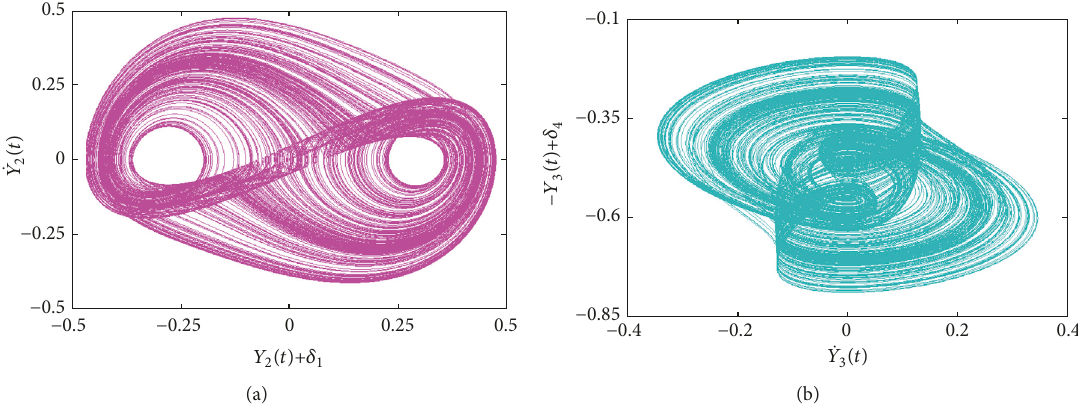
Figure 9: Transformed phase portraits of system (14) with a = 0.7, b = 10, 𝛿 1 = 𝛿 3 = 0, 𝛿 2 = 10 −6 , and 𝛿 4 = − 0.5. (a) Phase portrait in the [𝑌 (𝑡) + 𝛿 ] − ̇𝑌 (𝑡) plane. (b) Phase portrait in the ̇𝑌 2 1 2